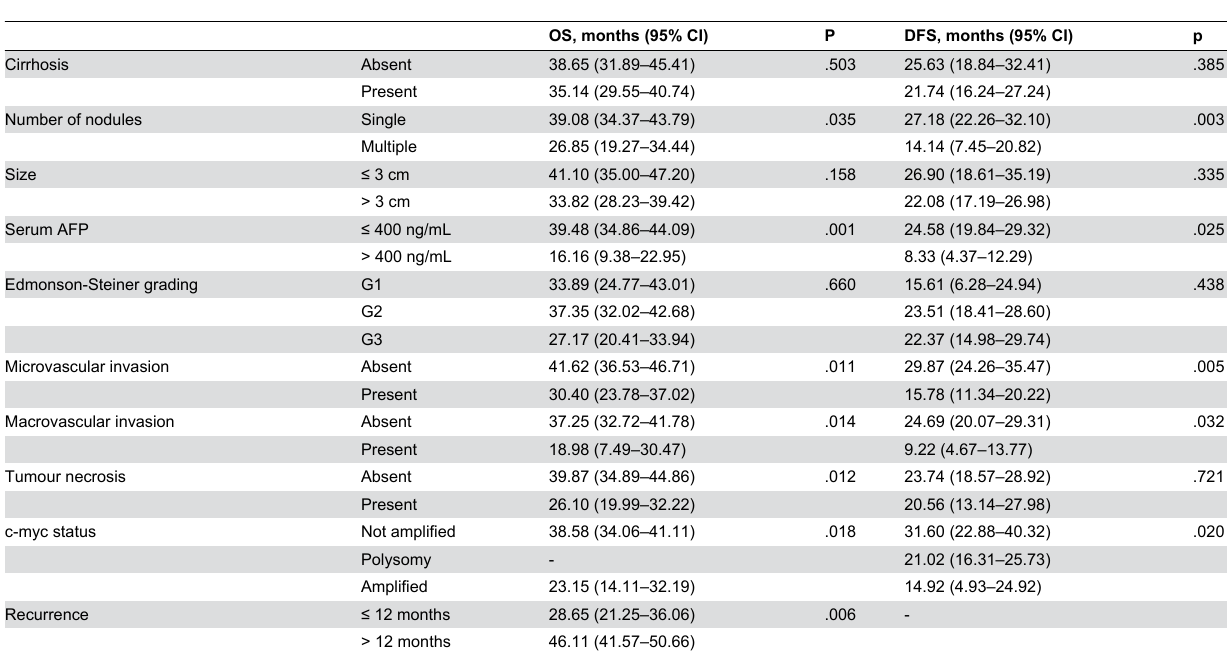
Table 3. Univariate analysis for overall survival (OS) and disease free survival